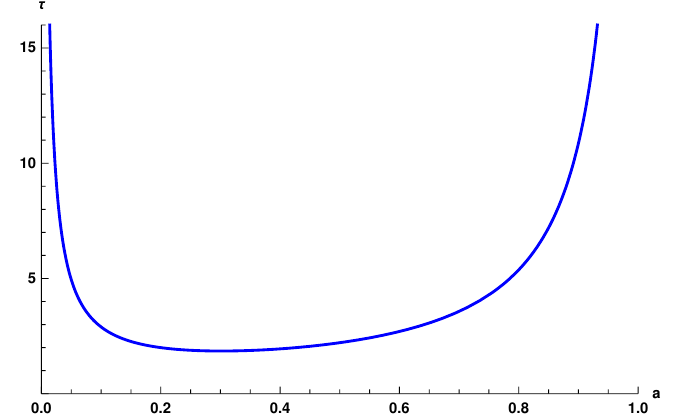
Figure 1 . The BPS temperature τ as a function of the rotation parameter a , when a = b and ϕ 0 = 0 . The large- τ extremes of the small and large black hole branches are shown by the divergences at a = 0 and a = 1